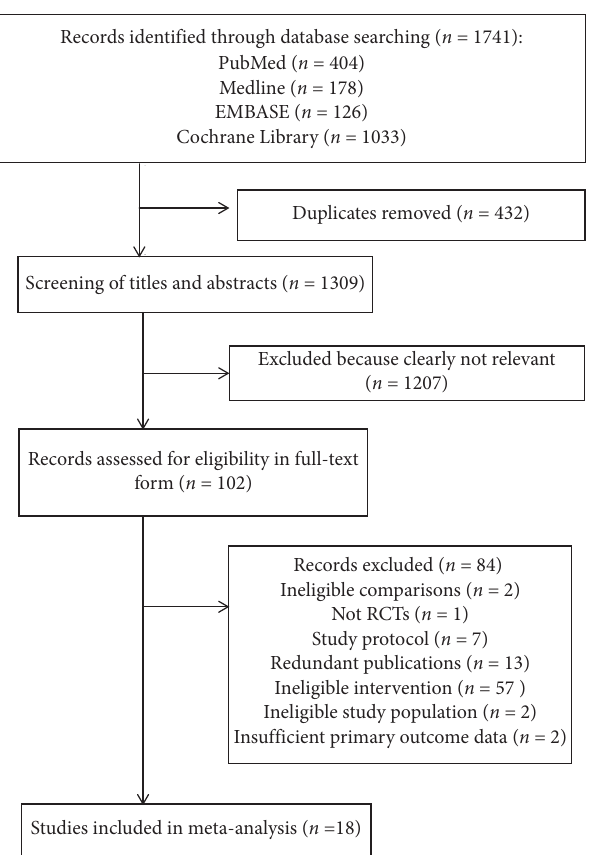
Figure 1: Flow diagram of study